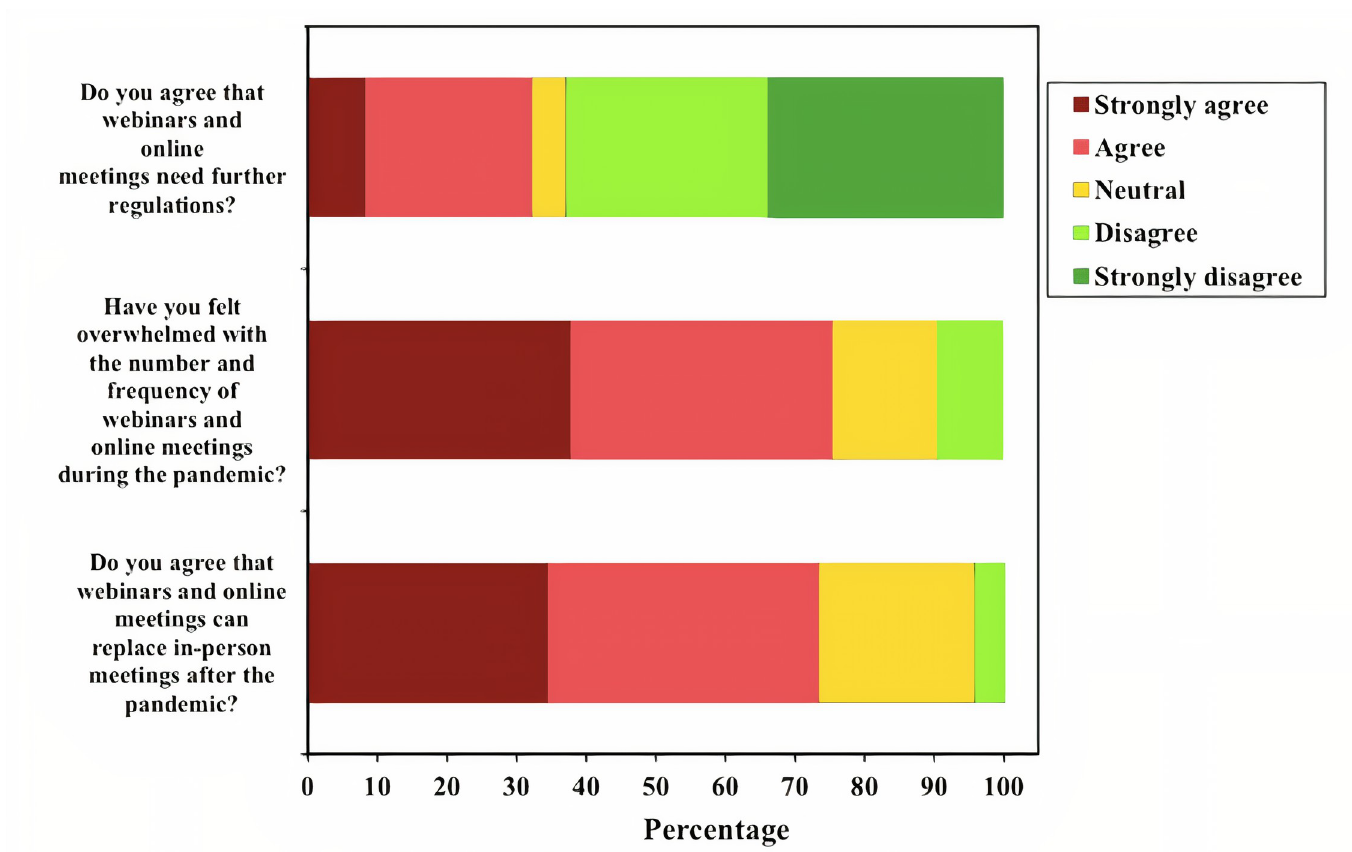
Fig 2. Stacked bar chart of Likert questions. The figure shows 3 bar charts describing the questions regarding being overwhelmed with webinars, the need for further regulations, and if webinars can replace traditional in-person methods after the